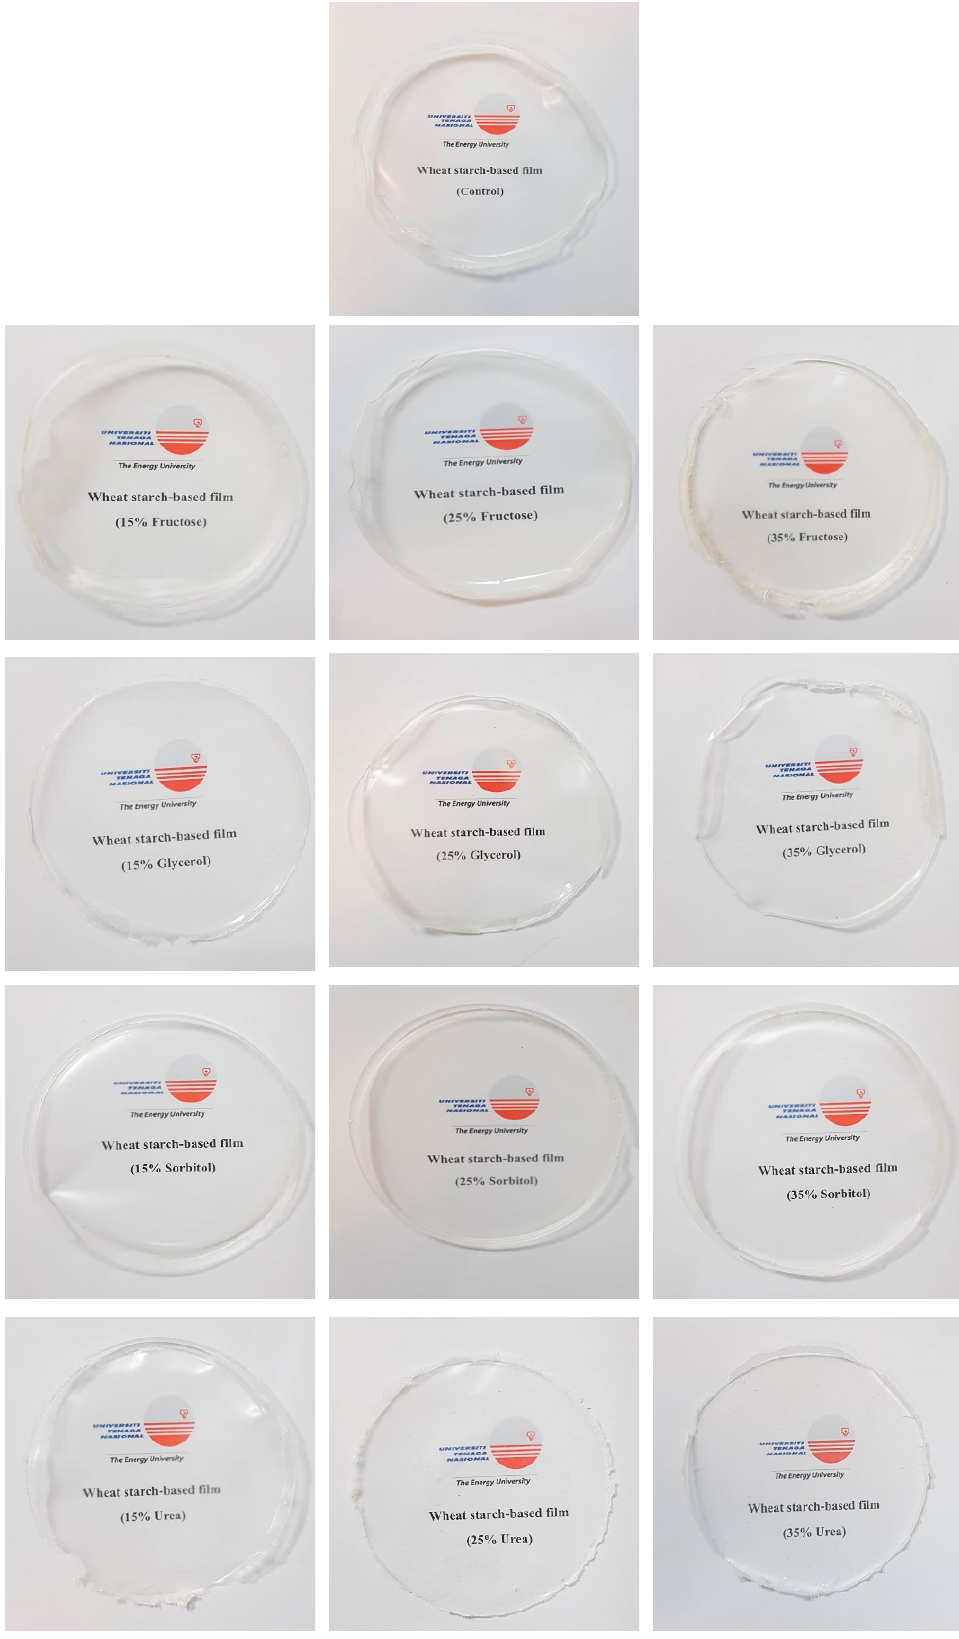
Figure 1. Different plasticized films produced.